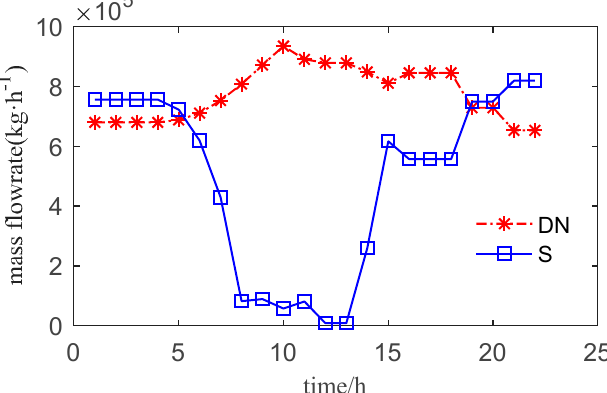
Figure 14. Trend chart of optimal operation parameters aiming at maximum GOR.